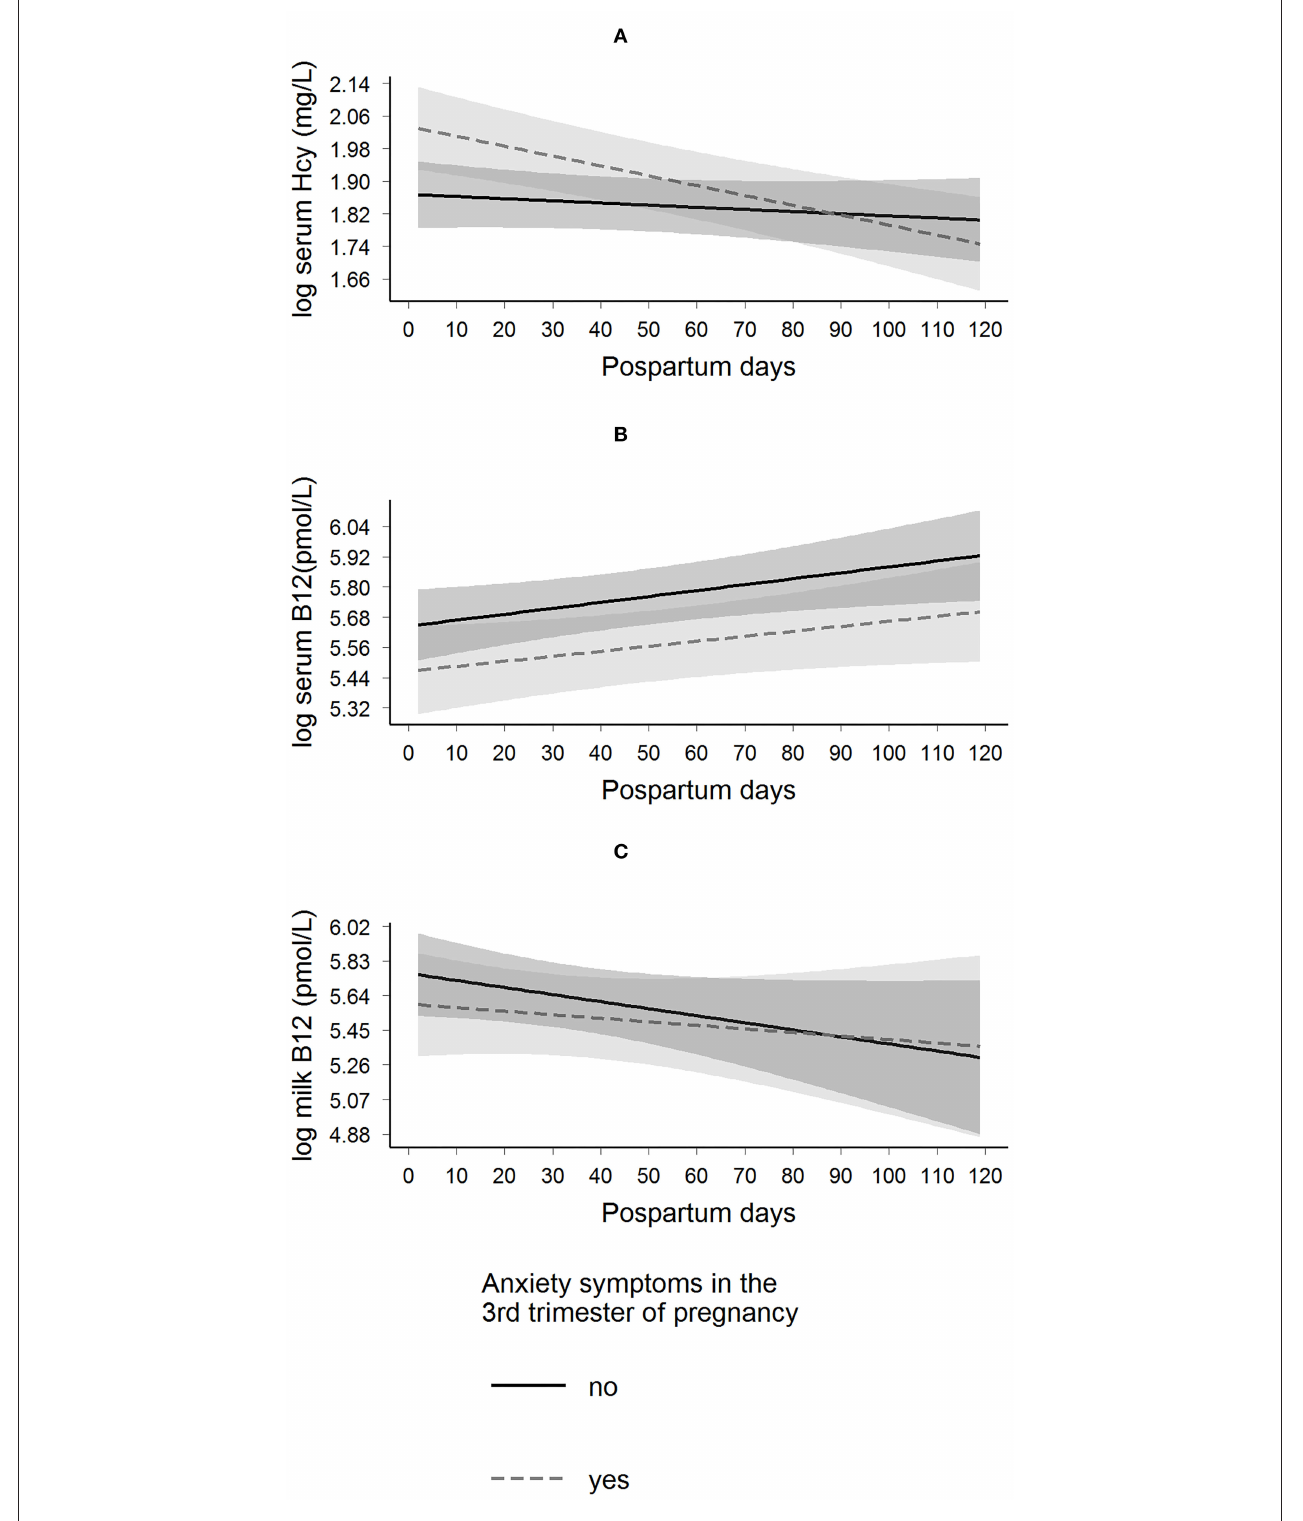
FIGURE 3 | Longitudinal predictions of maternal serum homocysteine, serum B-12, and milk B-12 concentrations according to the presence of anxiety symptoms in the 3rd trimester of pregnancy in Rio de Janeiro, Brazil. β Coefficient interactions ( β interaction ) and standard error (SE) were estimated. These parameters were used to evaluate the changes of having anxiety symptoms on the trajectory of each biological sample. Anxiety state was assessed by the State-Trait Anxiety Inventory (STAI),